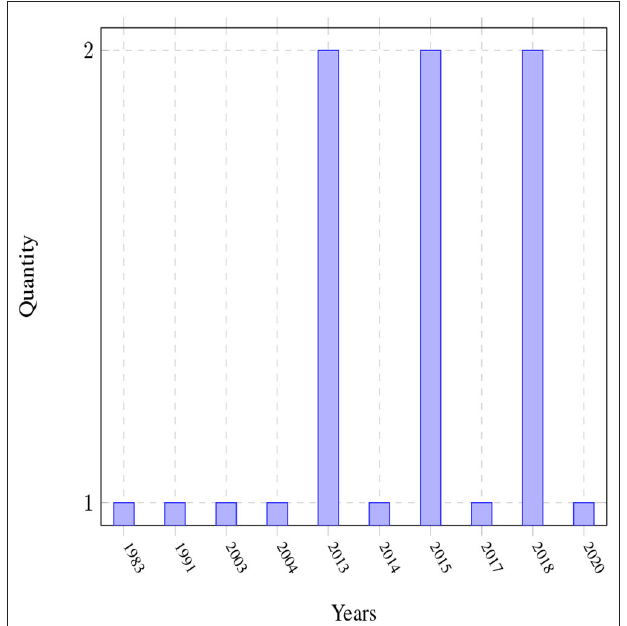
FIGURE 2 | Paper distribution by year of publication.